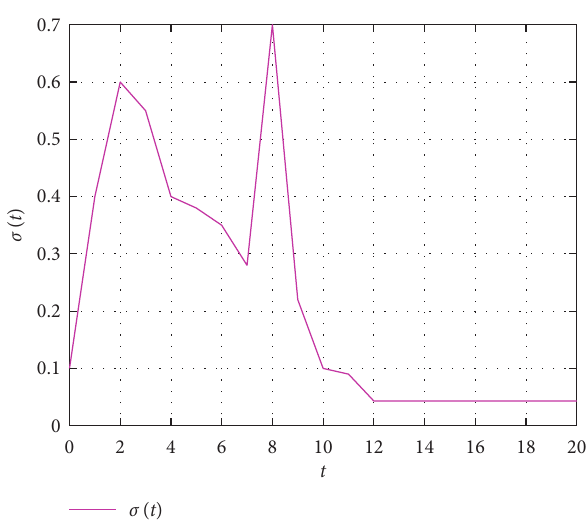
Figure 6: The threshold σ ( t ) of